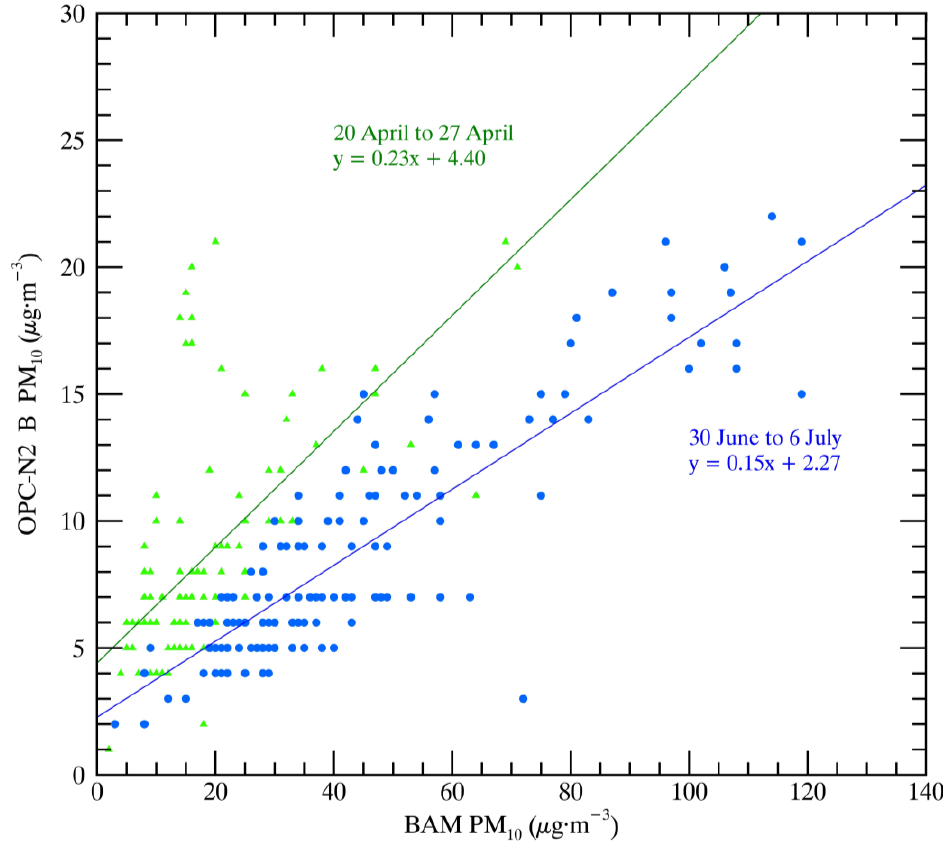
Figure 9. Linear regression of OPC-N2 B versus BAM PM 10 for the first (green) and last (blue) week of the study.